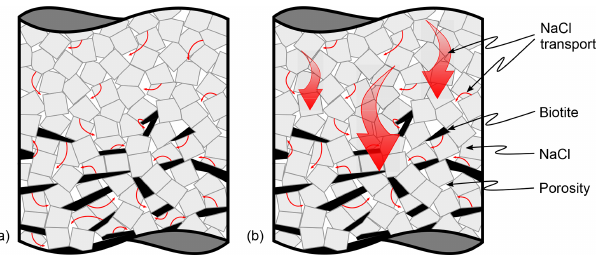
Figure 17. Possible transport length scales during dissolution– precipitation creep as proposed within the scope of this work. In panel (a) , diffusion occurs only on the grain scale as described in the classical literature. In panel (b) , we added diffusive transport on longer length scales as described in Merino et al. (1983). However, diffusive transport on the grain scale is considered to be active as